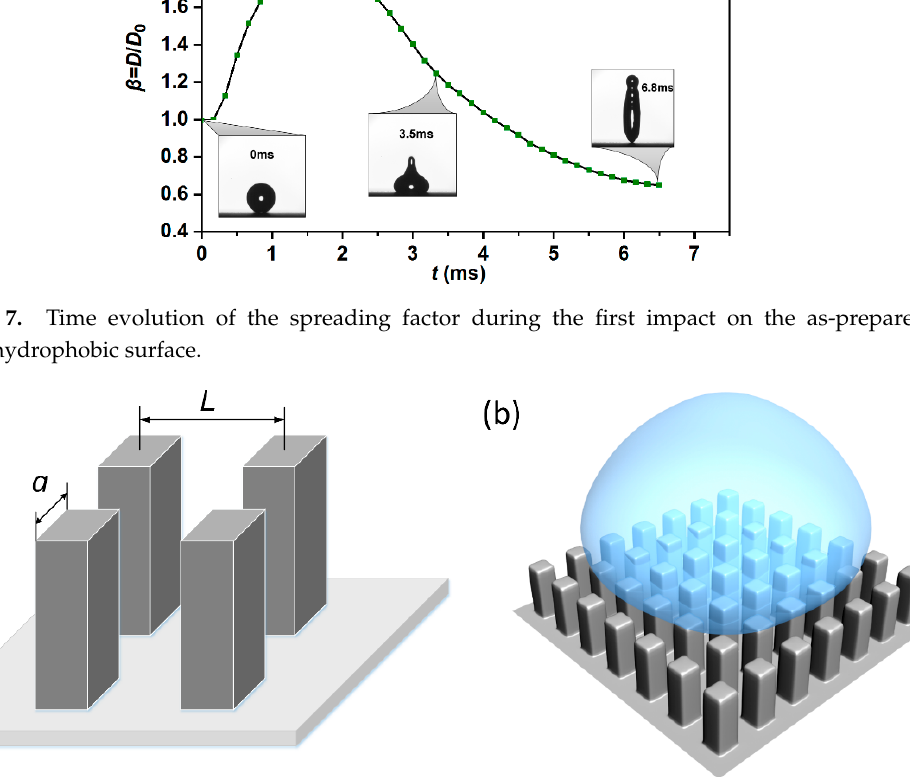
Figure 8. ( a ) The definition length for the micro-pillars and ( b ) the composite wetting state of a droplet during the spreading process.